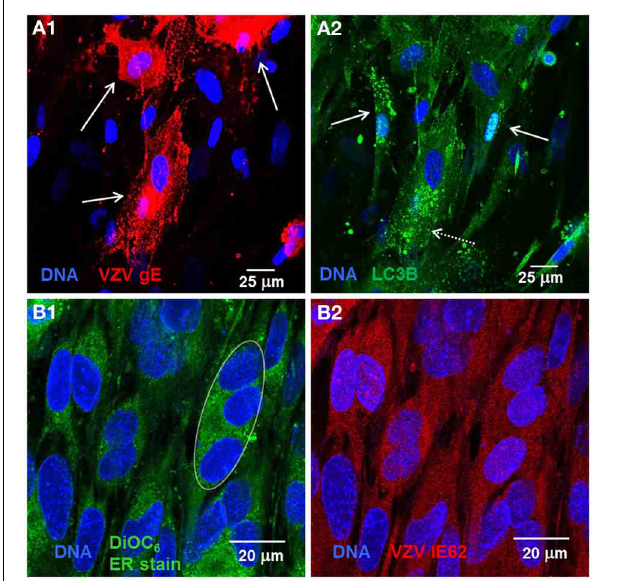
FIGURE 1 | VZV infected cells exhibited abundant glycoprotein expression, increased autophagosomes, and an enlarged ER. Human fibroblast cells (MRC-5) were grown on glass coverslips in tissue culture plates until 60% confluent and then infected with VZV-32 infected MRC-5 cells at a ratio of 1:8. At 48hpi, the cultures were fixed, permeabilized, blocked and immunolabeled for VZV gE, IE62, or cellular LC3B. The cells were then imaged at 400 × with a Zeiss 710 confocal fluorescence microscope. Other cultures grown and infected similarly were incubated in medium containing DiOC6, a polar dye, prior to fixation. (A1) VZV glycoprotein gE expression is abundant in three cells (solid arrows) in the image. (A2) LC3 puncta indicative of autophagosomes are apparent in cells expressing gE (arrows, dashed line) and nearby cells that are newly infected (arrows, solid line). (B1) DiOC 6 staining in 19 cells at 630 × . A representative white ellipse indicates the enlarged ER in an infected syncytium. (B2) VZV IE62 staining indicates that all 19 cells are infected and several are in